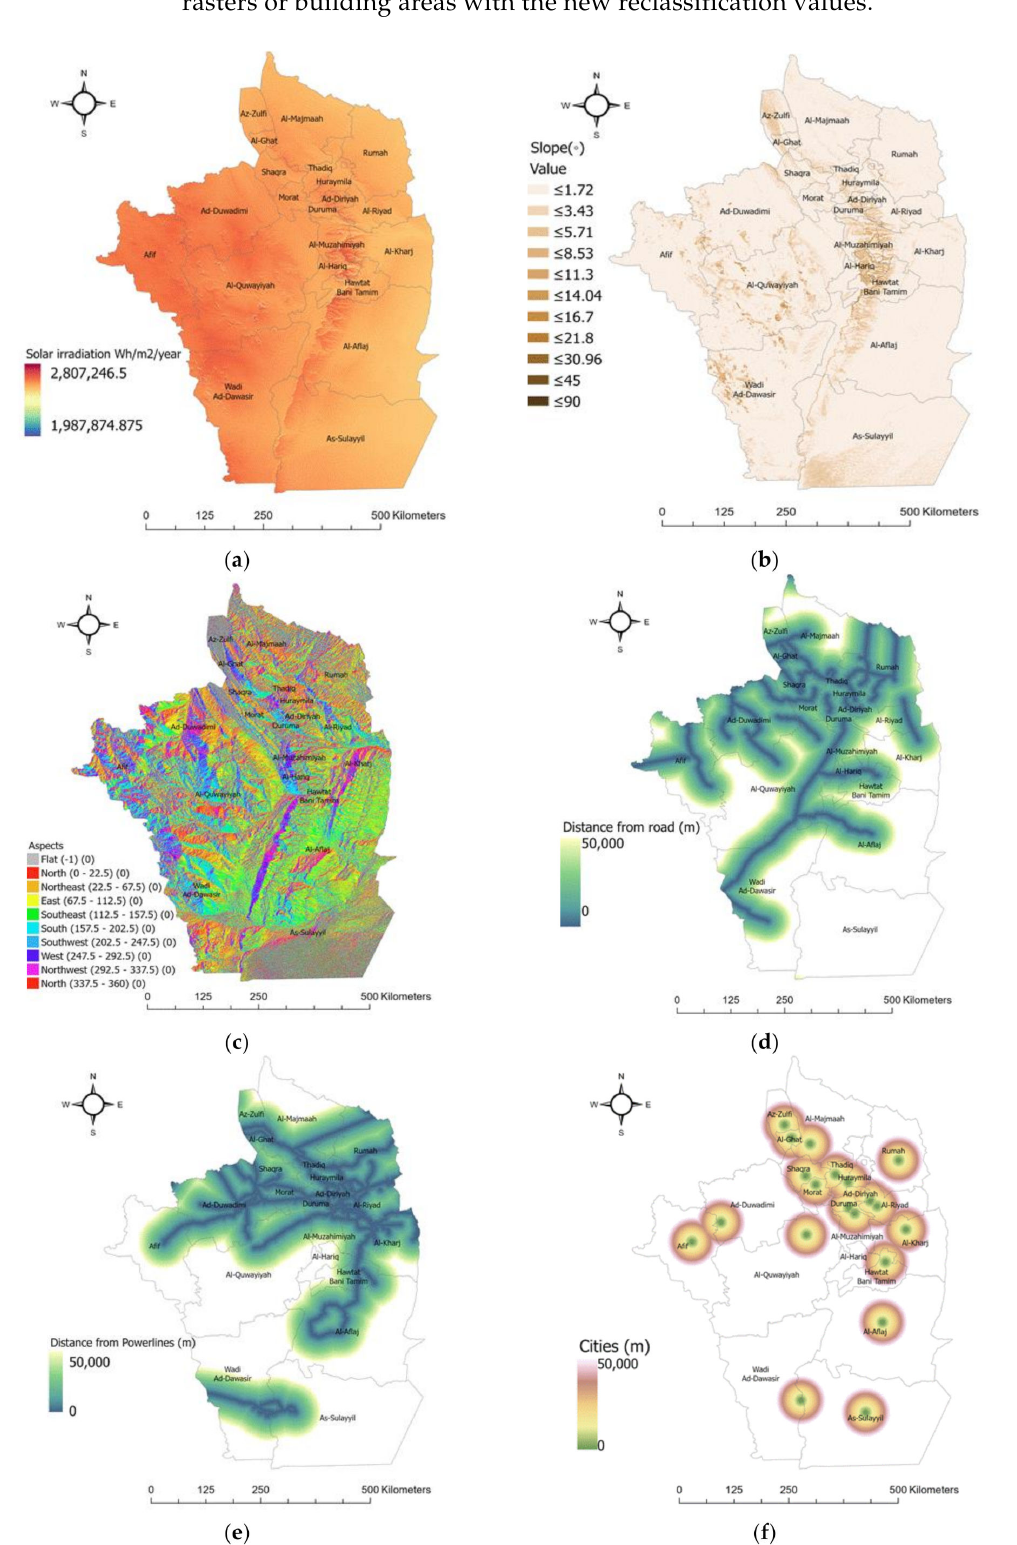
for electricity with the new reclassification values. Figure 5e represents the distance rasters or building areas with the new reclassification values.